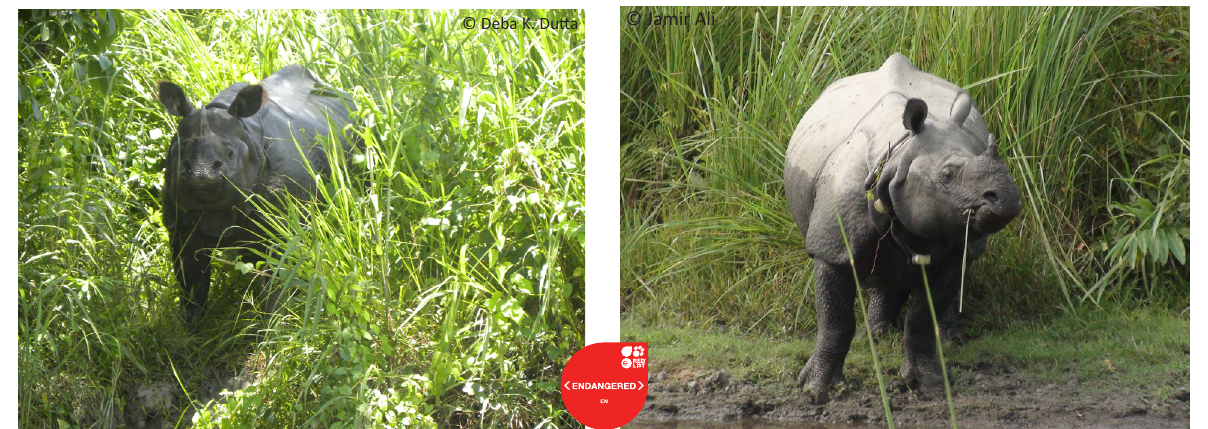
Figure 2. Manas National Park,